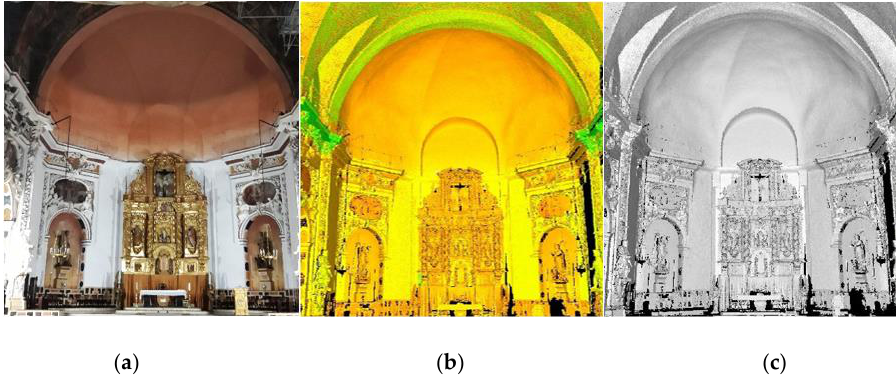
Figure 1. ( a ) Photograph of the altar and the vault on it. ( b ) Complete three-dimensional cloud (laser). ( c ) 3D model